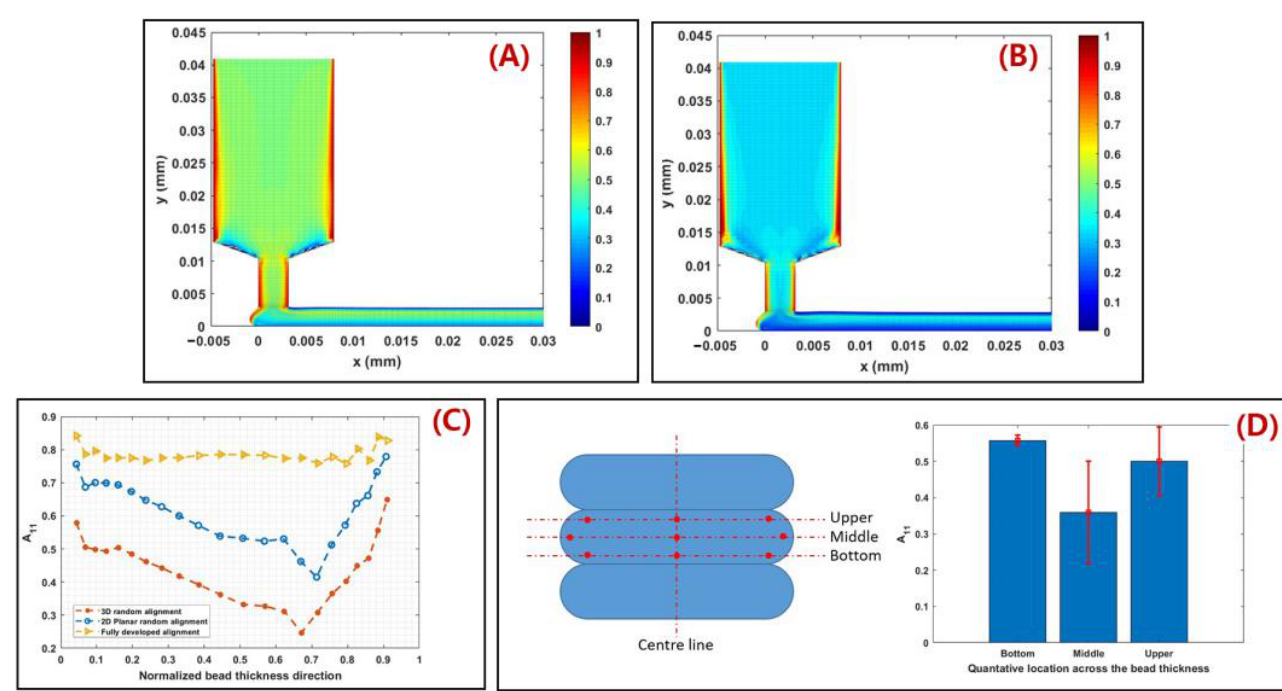
Figure 10. ( A ) Fiber orientation tensor A 33 component contour of 2D planar deposition flow with assumed 3D random fiber alignment initial condition at nozzle inlet; ( B ) Fiber orientation tensor A 33 component contour of 2D planar deposition flow with assumed 2D planar random fiber alignment initial condition at nozzle inlet; ( C ) A 33 component at flow end with different assumed initial fiber orientation conditions; ( D ) Measured fiber orientation tensor component A 33 [122].